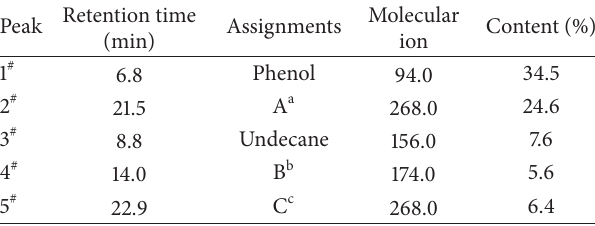
Table 2: GC/MS results of the